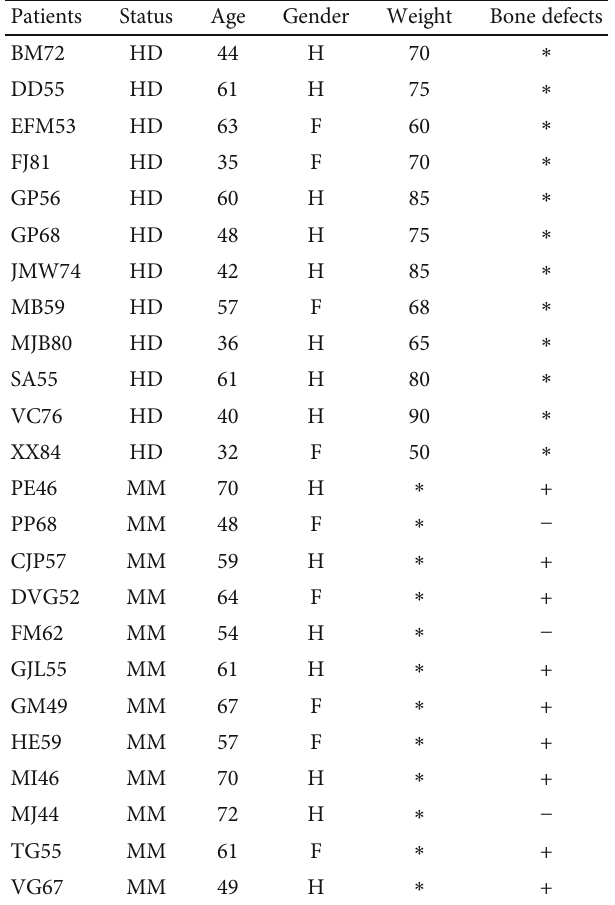
Table 1: Characteristics of healthy donor (HD) and multiple myeloma (MM) patients (related to Figure